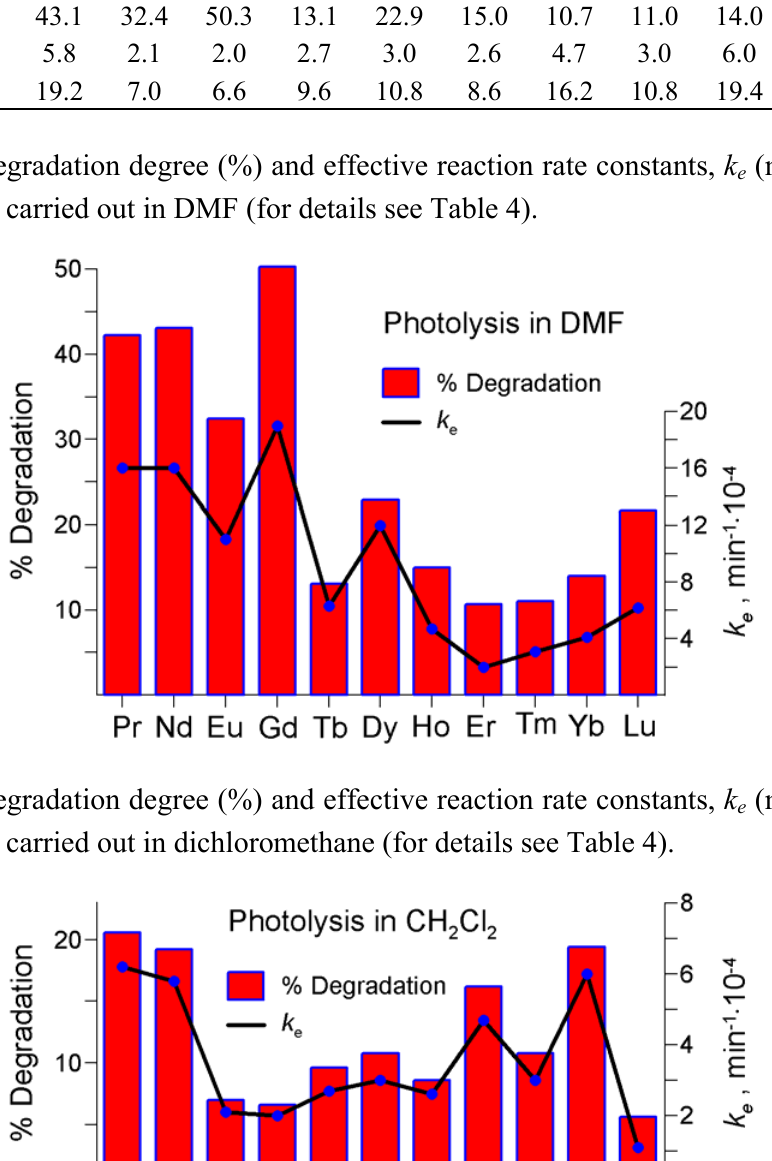
Table 4. Photolysis effective rate constant, k photodegradation, δ (%) determined from kinetic curves A = f(t) for the B-band in DMF and dichloromethane (DCM) after 360 min of UV-irradiation. * ) For H UV-irradiation, k and δ estimated for the Q-band. e